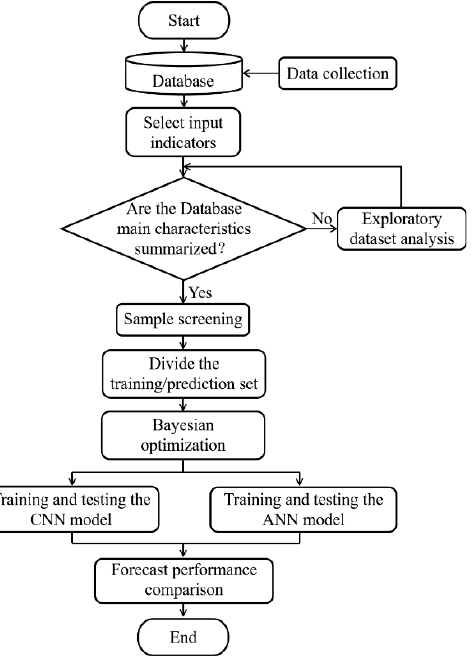
Figure 3. A comparative study of a fully-connected ANN and CNN implementation framework.